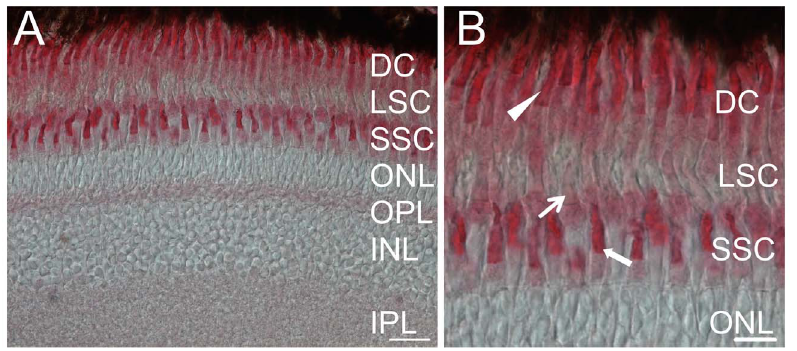
Figure 3. Immunostaining of zGC3 in cryosections of adult zebrafish retina. Sectionas were probed with the anti-zGC3 antibody (1:400). The secondary antibody was used at 1:200 dilution. (A) Section of a whole retina, cell layers are indicated as double cones (DC), long single cones (LSC), short single cones (SSC), outer nuclear layer (ONL), outer plexiform layer (OPL), inner nuclear layer (INL) and inner plexiform layer (IPL). (B) Magnified part of (A). DC: closed arrowhead; LSC: thin arrow; SSC: bold arrow. Scale bar =20 m m in (A) and 10 m M in (B).